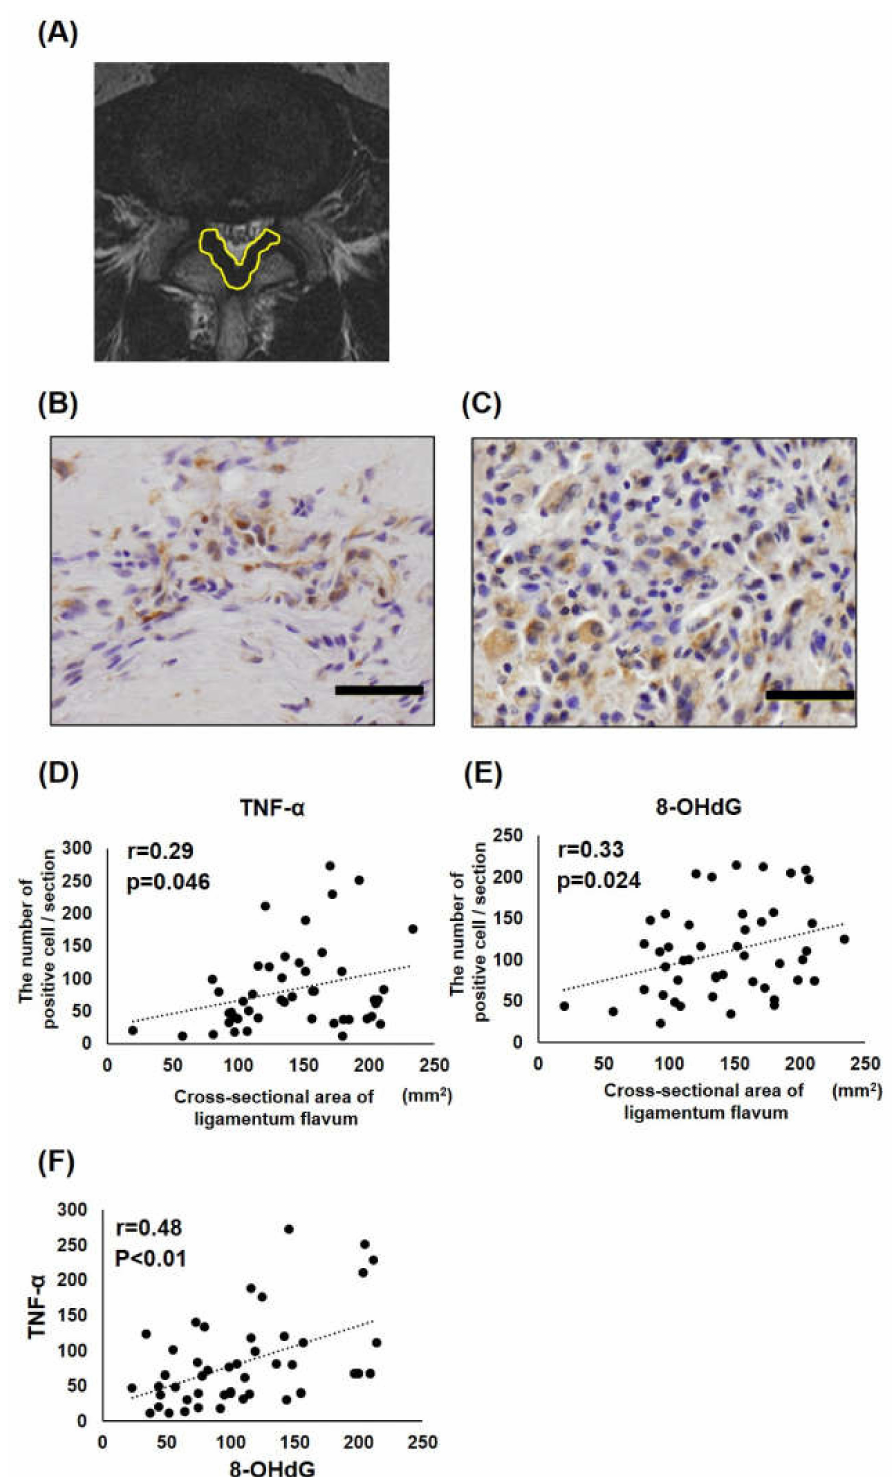
Figure 1. Correlation between 8-OHdG or TNF- α expression and ligamentum flavum (LF) hypertro- phy. ( A ) Measurement of the cross-sectional area (CSA) of LF under axial MRI. ( B , C ) Representative immunohistochemistry data for TNF- α ( A ) and 8-OHdG ( B ) in human LF samples. Scale bars, 50 µ m. ( D , E ) Correlation between the positive cell number of TNF- α ( C ) or 8-OHdG ( D ) and the LF cross-sectional area on axial lumbar magnetic resonance imaging. ( F ) Correlation of the positive cell number of TNF- α and